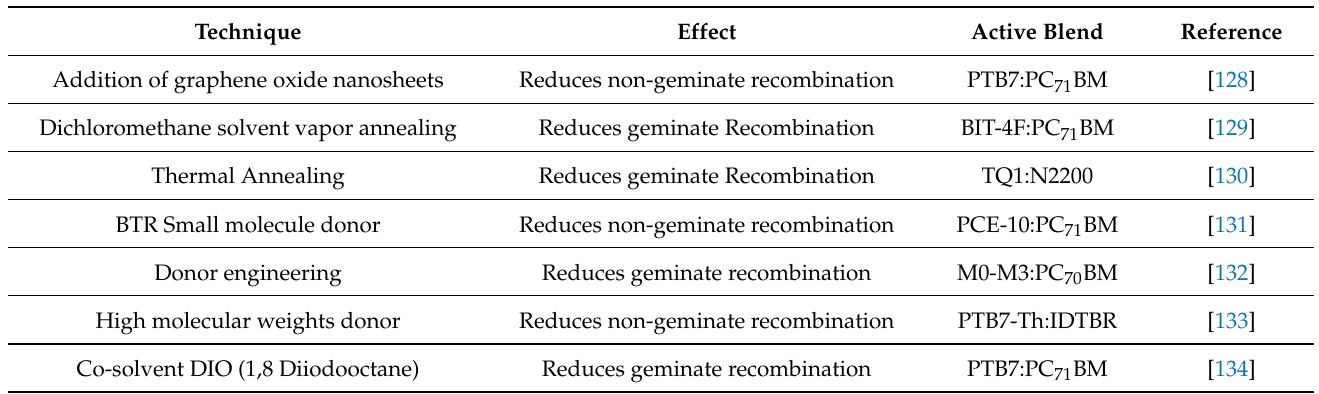
Table 2. Effect of different preparation techniques on recombination in different organic solar